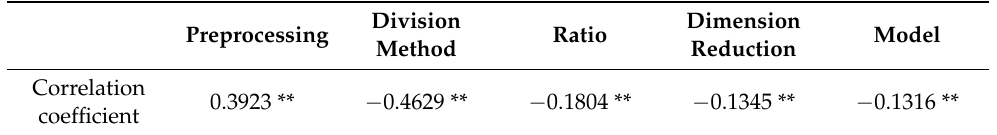
Table 2. Correlation between each factor and RMSE v . Division Dimension Preprocessing Ratio Model Method Reduction Correlation 0.3923 ** − 0.4629 ** − 0.1804 ** − 0.1345 ** − 0.1316 coefficient